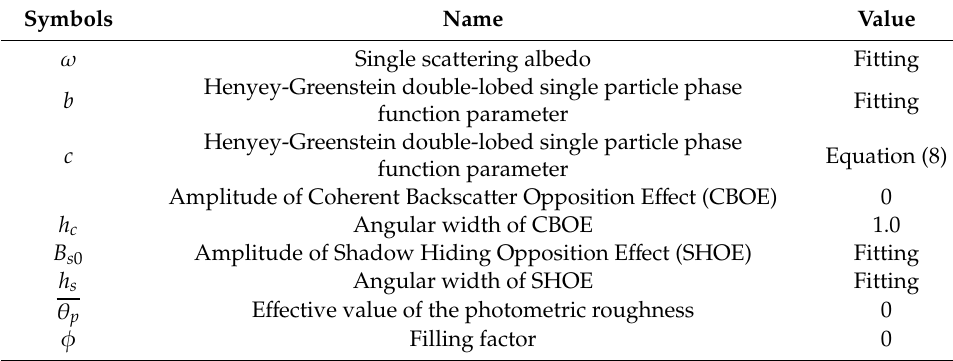
Table 3. Calculation of Hapke parameters in this study.